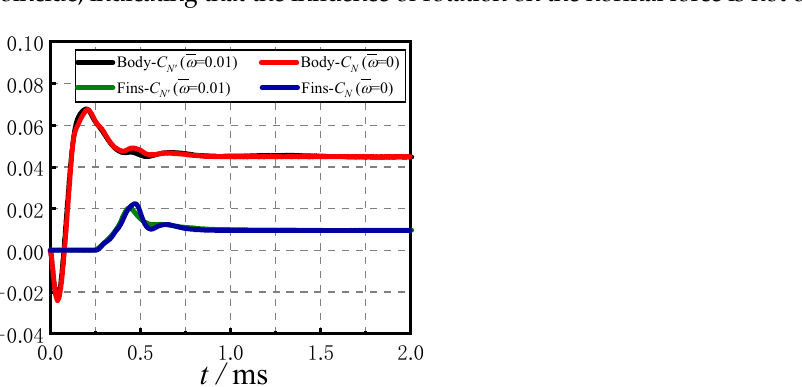
Figure 15. Variation of aerodynamic coefficients of different aerodynamic components with time since lateral jet startup: ( a ) Normal force coefficient; ( b ) lateral force coefficient.